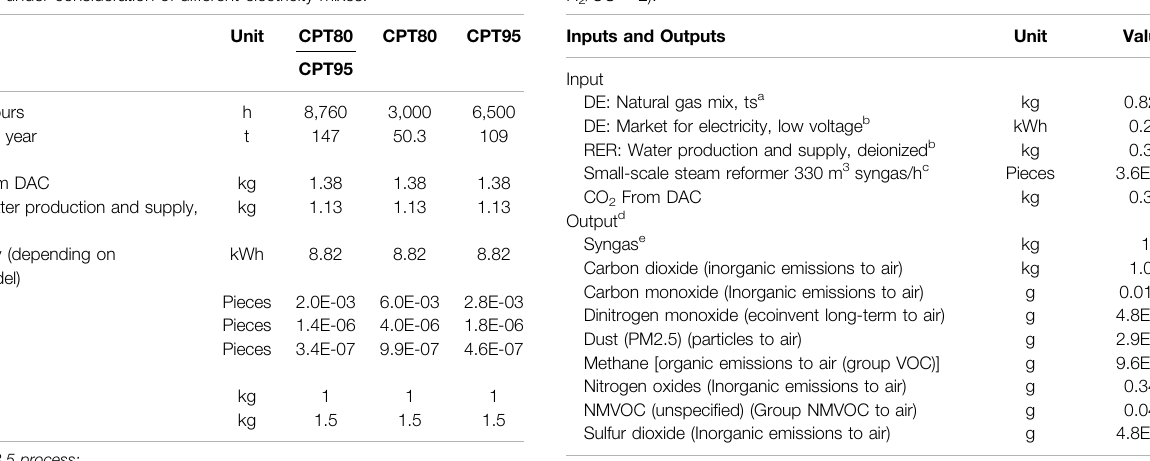
TABLE 3 | Operation of small-scale SMR to produce 1 kg of syngas (molar ratio H 2 /CO (cid:1)